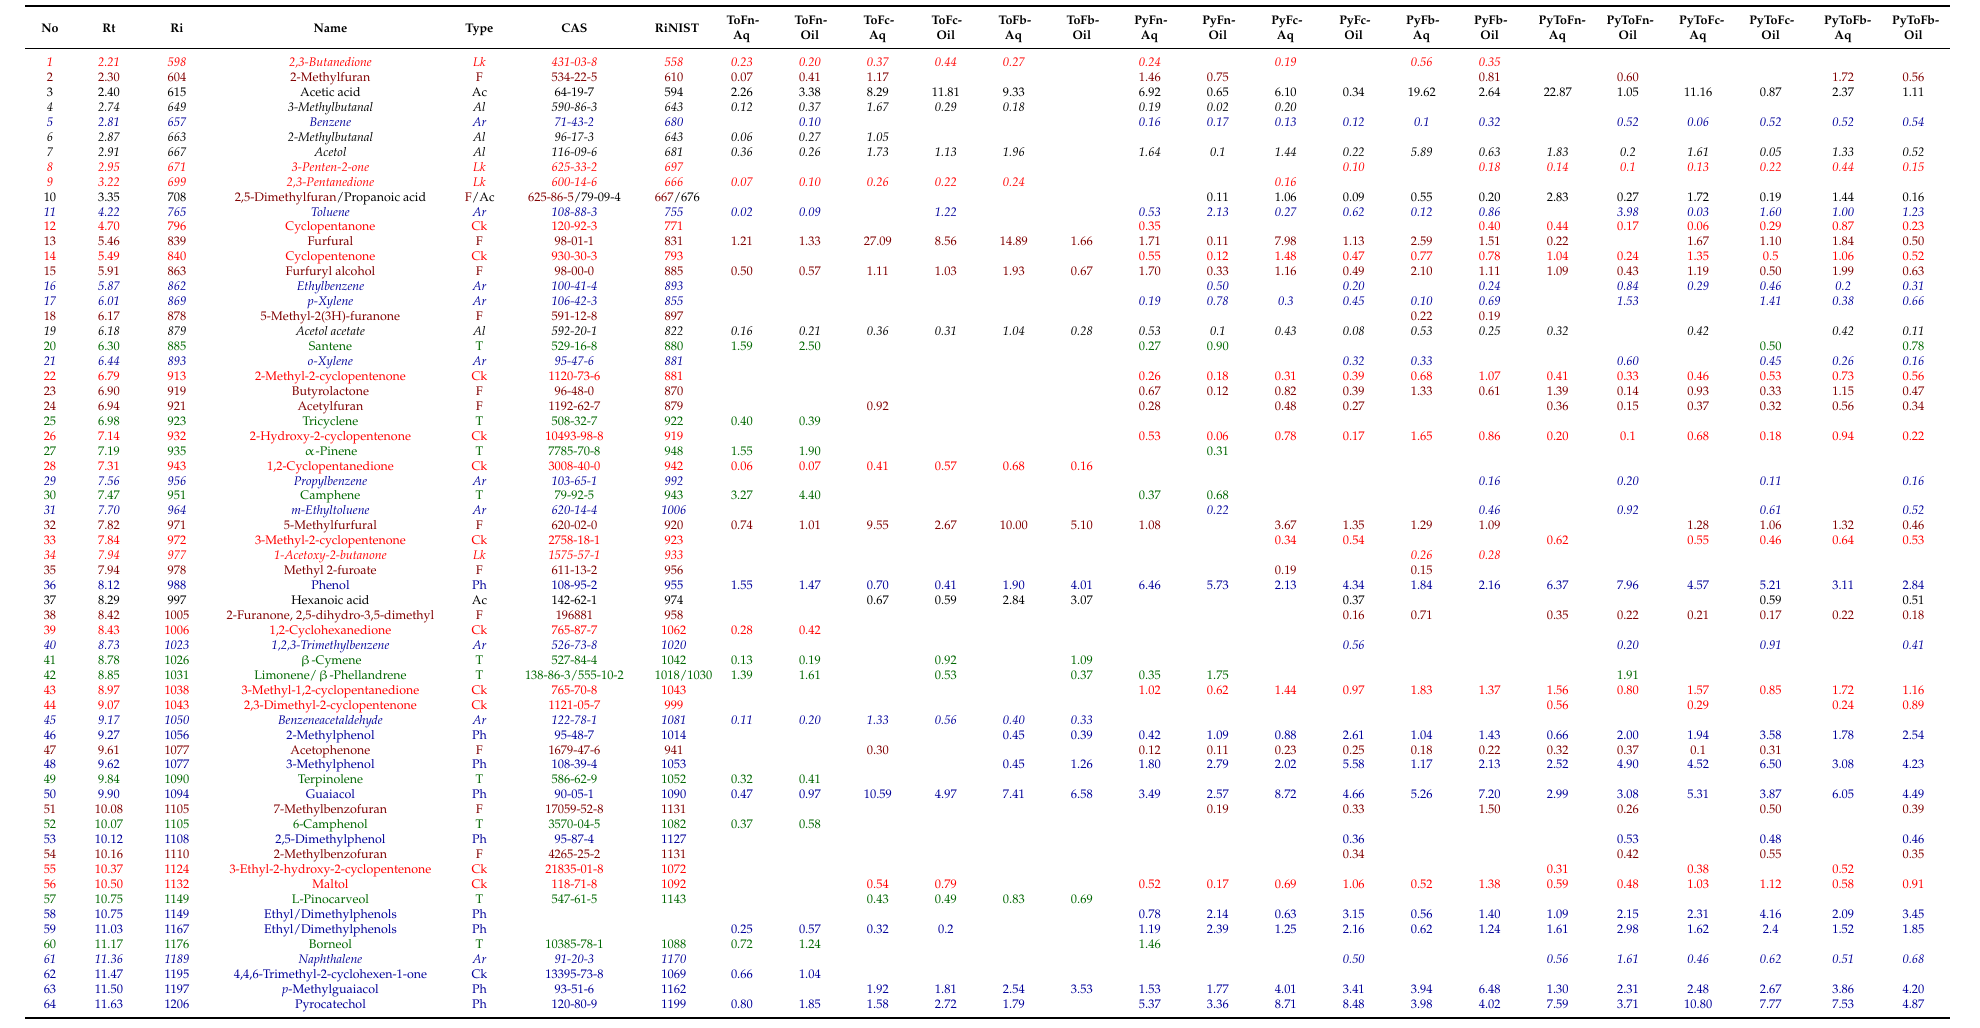
Table 2. The composition (GC–MSD peak area %, ± 5% associated error) of aqueous and oil fractions from torrefaction and/or pyrolysis of fir needles, cones and